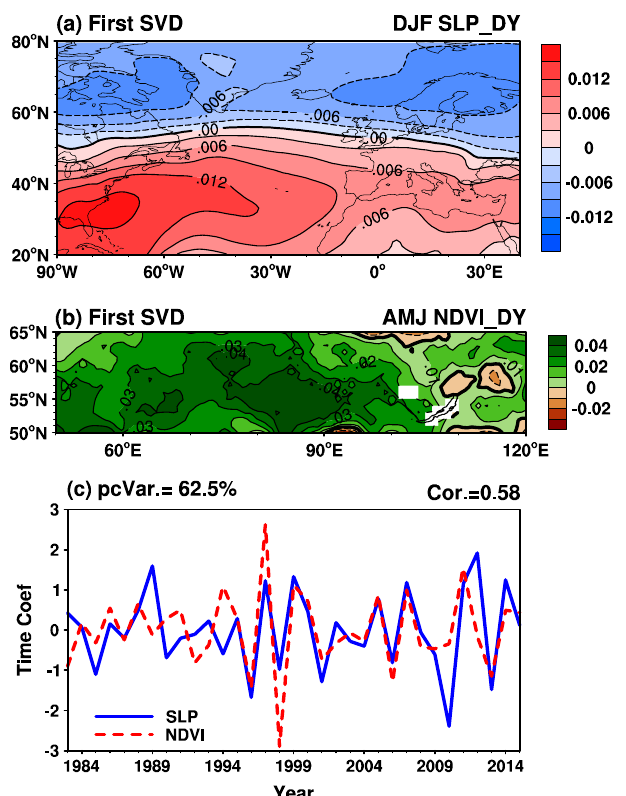
Figure 6. Spatial patterns for the first paired mode of the DY of ( a ) winter (December–January–February (DJF)) sea surface temperature (SST, tropical Pacific) and ( b ) spring (April–May–June (AMJ)) NDVIEA via SVD analysis during 1983–2015. ( c ) The corresponding normalized time series of the expansion coefficients for the paired mode; their correlation coefficient is shown above the top right-hand corner, and the variance explained by the first mode is shown above the top left-hand corner.